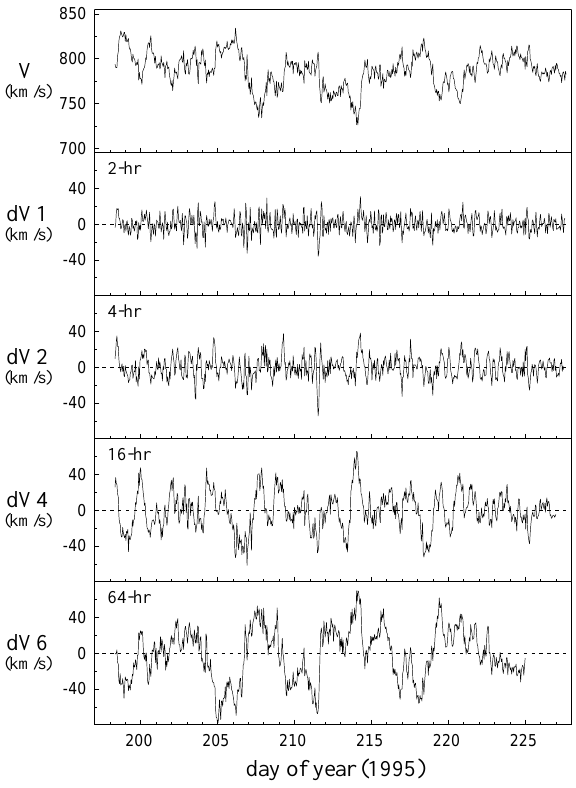
Fig. 4. Solar wind velocity V and velocity differences dV 1, dV 2, dV 4, and dV 6 for a solar rotation at the top of the Ulysses’ northern